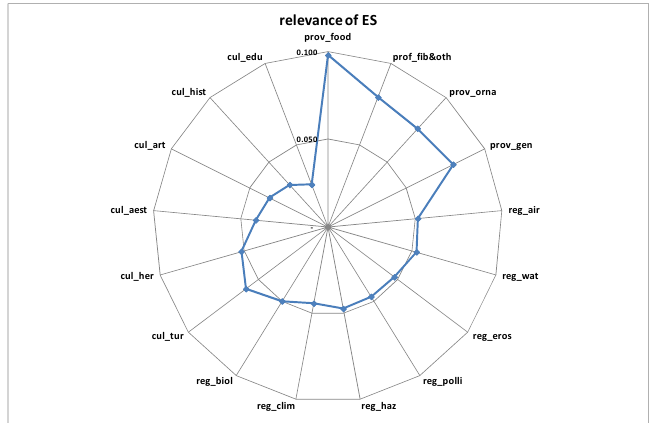
Figure 4. Relative importance (weights) of ES.